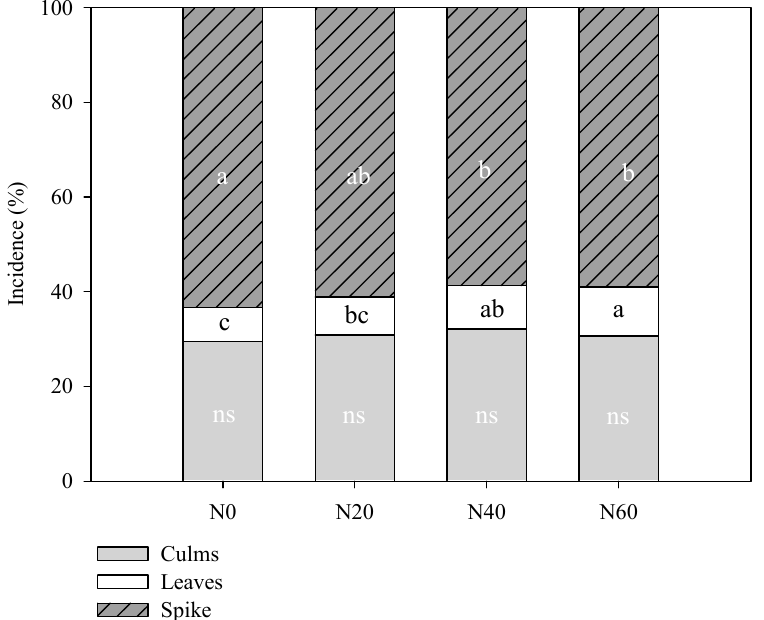
Figure 2. Culms, leaves and spikes percentage of barley as affected by nitrogen fertilization levels (not fertilized = N0; fertilized with 20 kg N ha − 1 = N20; fertilized with 40 kg N ha − 1 = N40 and fertilized with 60 kg N ha − 1 = N60). Different letters indicate significant differences according to Duncan’s test ( p < 0.05). ns = non-significant.